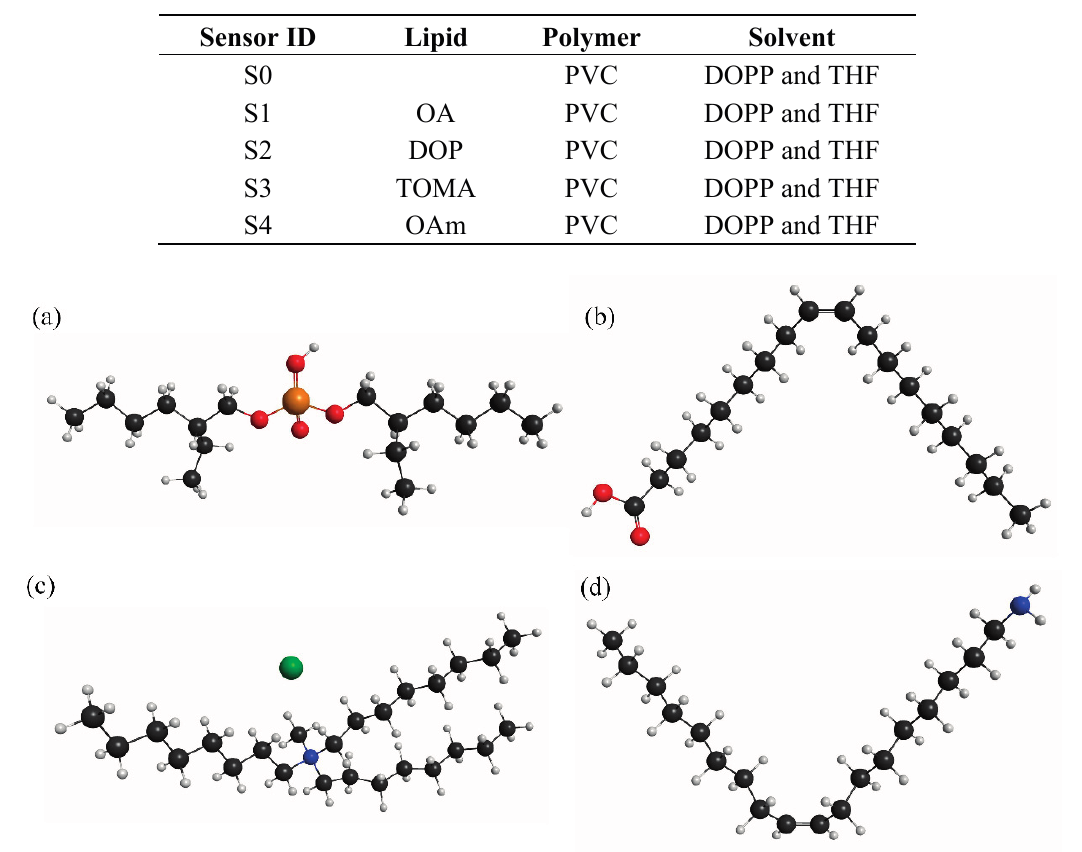
Table 1. The composition of each sensing solution of the sensor array. OA, oleic acid; DOP, dioctyl phosphate; TOMA, trioctylmethylammonium chloride; OAm, oleyl amine; PVC,